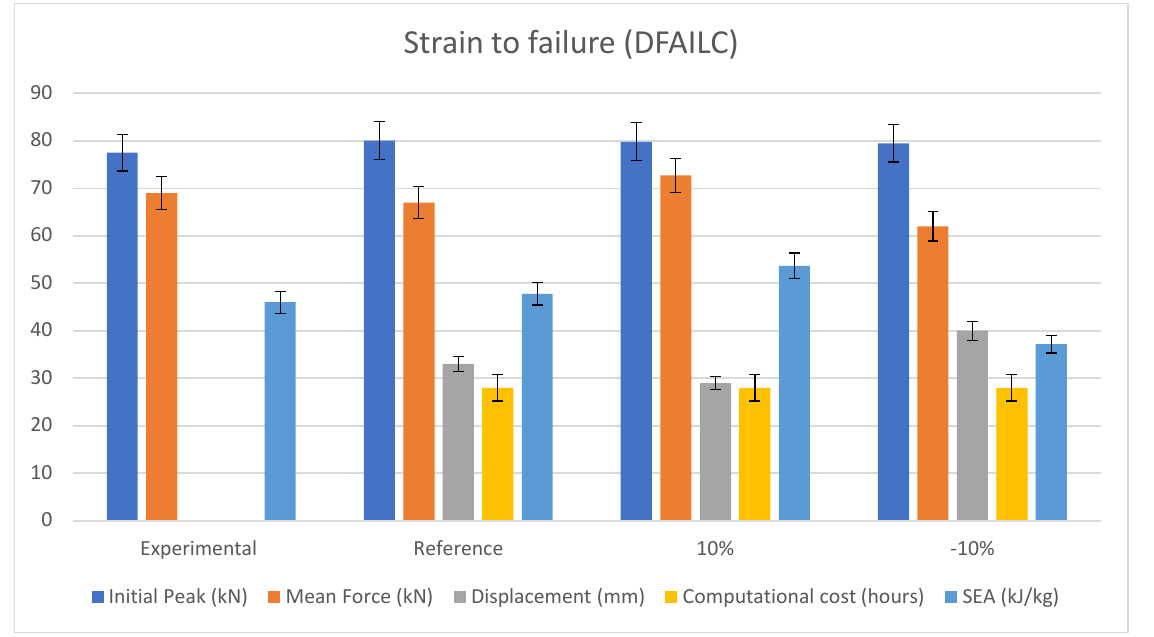
Figure 15. Strain to failure in compression (DFAILC) [66].